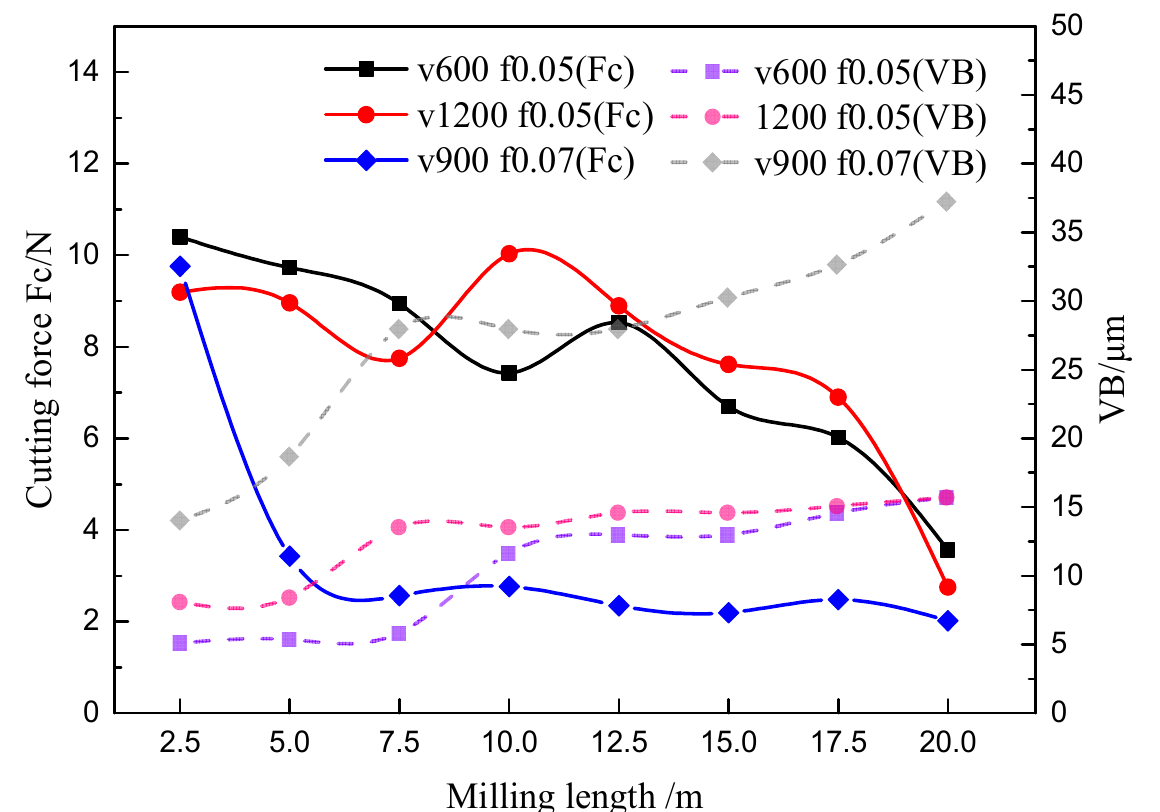
force and the wear land width of flank face changes dramatically during the formation of